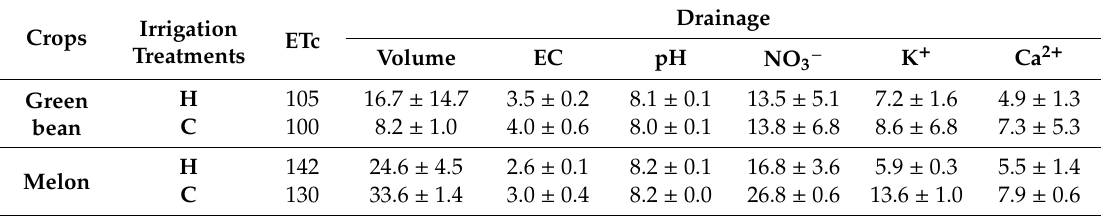
Table 3. Crop evapotranspiration (ET c , mm), and drainage volume (mm) and composition of green bean and melon crops grown under high (H) and conventional (C) soil water availability treatments. Mean seasonal values of electrical conductivity (EC, dS m − 1 ) and pH, and cumulative seasonal values (g m − 2 ) of nitrates (NO 3 − ), potassium (K + ) and calcium (Ca 2 + ) collected in the drainage. The